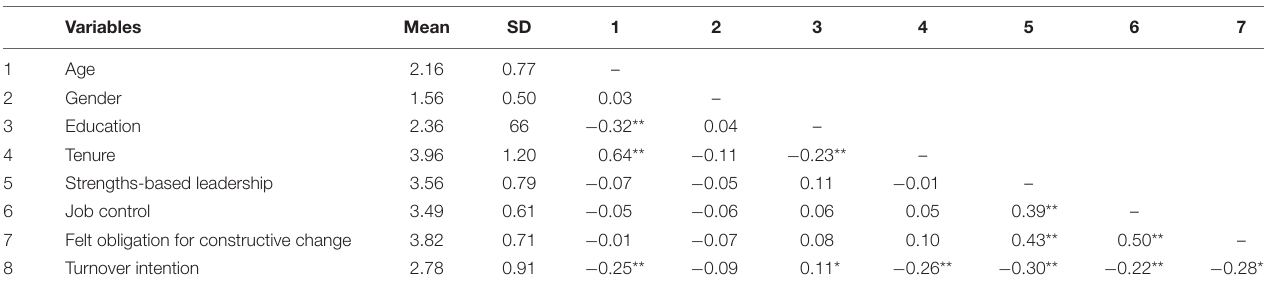
TABLE 3 | Descriptive statistics and correlations ( N =